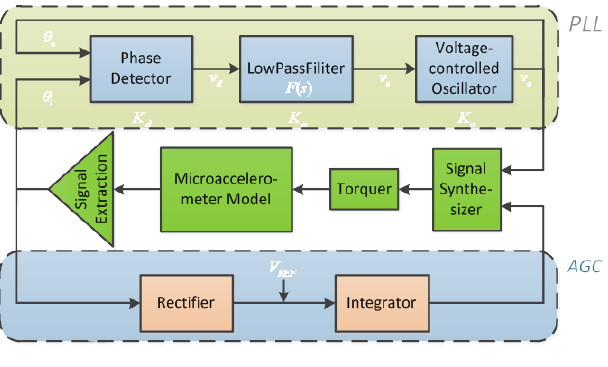
Figure 11. The closed-loop drive circuit diagram of the micromechanical silicon resonant